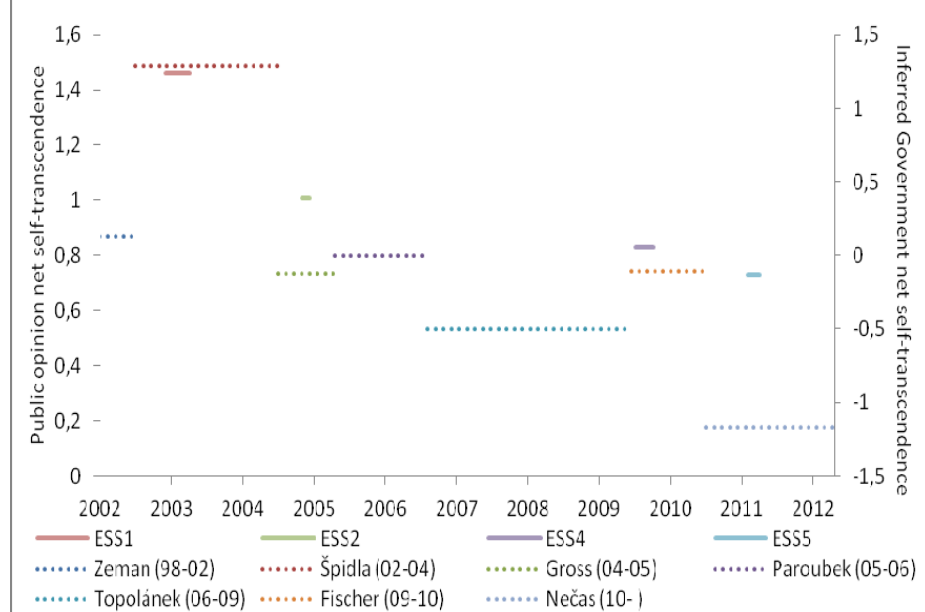
Figure 9: Net self-transcendence for the Czech Republic